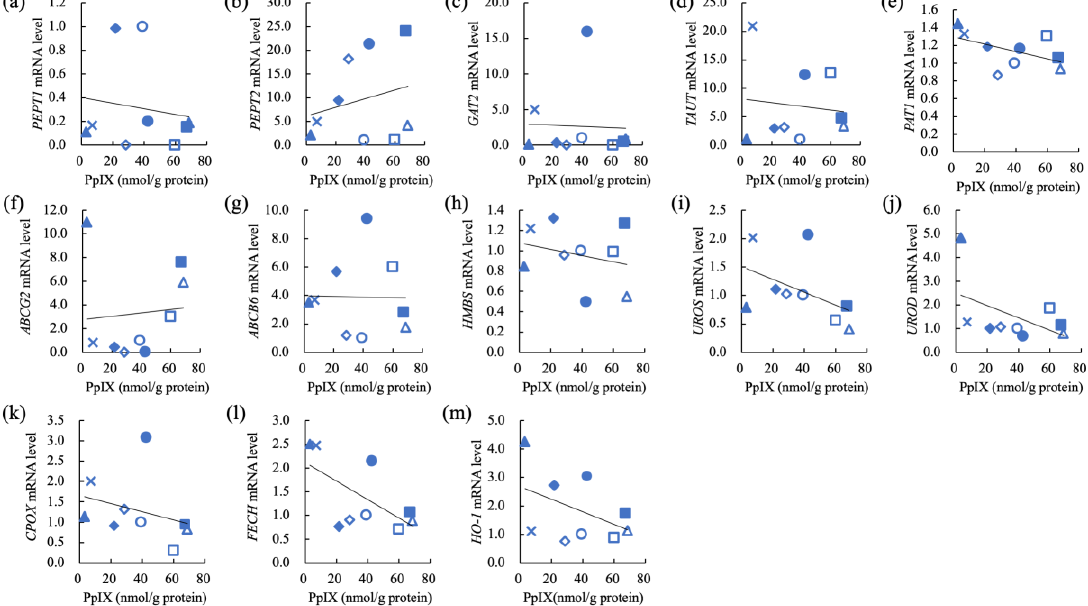
Table 4. Correlation of PpIX concentration and relative mRNA levels in carcinomas and sarcomas. PpIX vs.